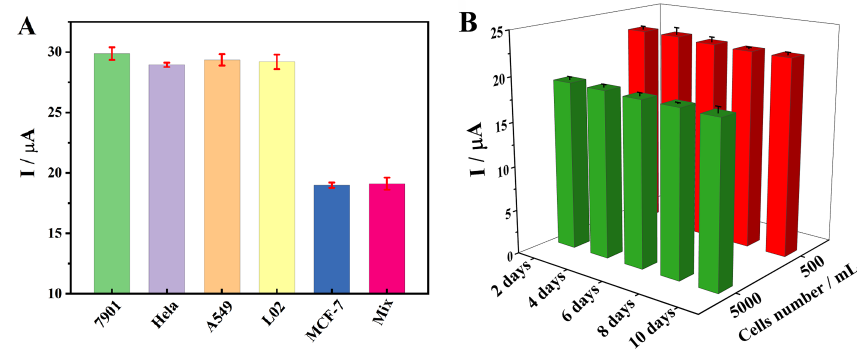
Figure 6. The specificity ( A ) and stability ( B ) of MCF-7 cell sensor. Table 2. Detection of MCF-7 in PBS and human whole-blood samples (n = 3).